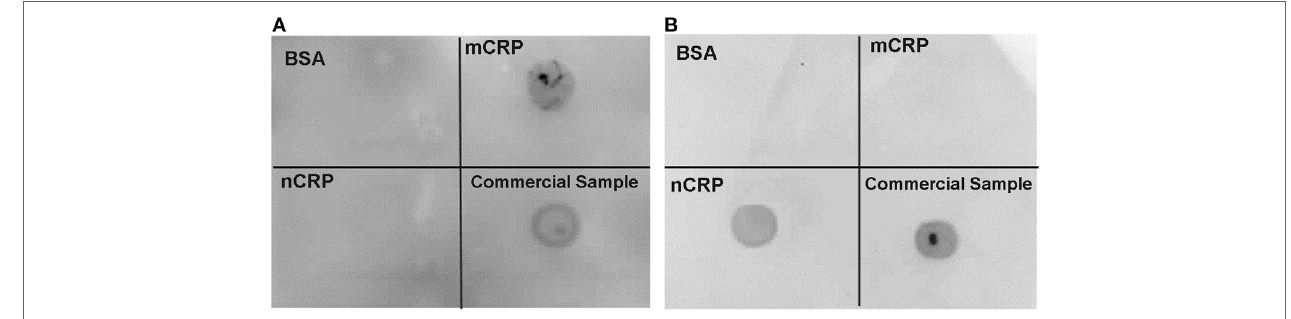
FigUre 2 | Immunoblot confirming purity of C-reactive protein (CRP) isoforms. Immunoblotting confirmed the presence of monomeric CRP (mCRP) alone (a) and native CRP (nCRP) alone (B) in purified samples. Both membranes included blots for a non-specific bovine serum albumin negative control protein, the